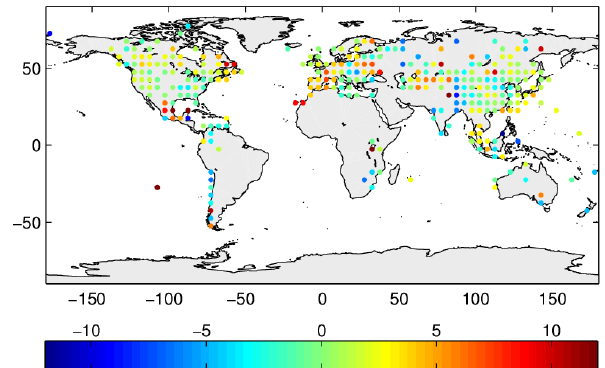
Fig. 12. The linear trend of R s from 1982 to 2008 (unit: Wm − 2 per decade) from merged SunDu-derived values and direct measurements collected by GEBA. The trends are first calculated at each station and then aggregated into a 5 ◦ × 5 ◦ grid and the averages are shown. There are 302 such grids obtained and shown.